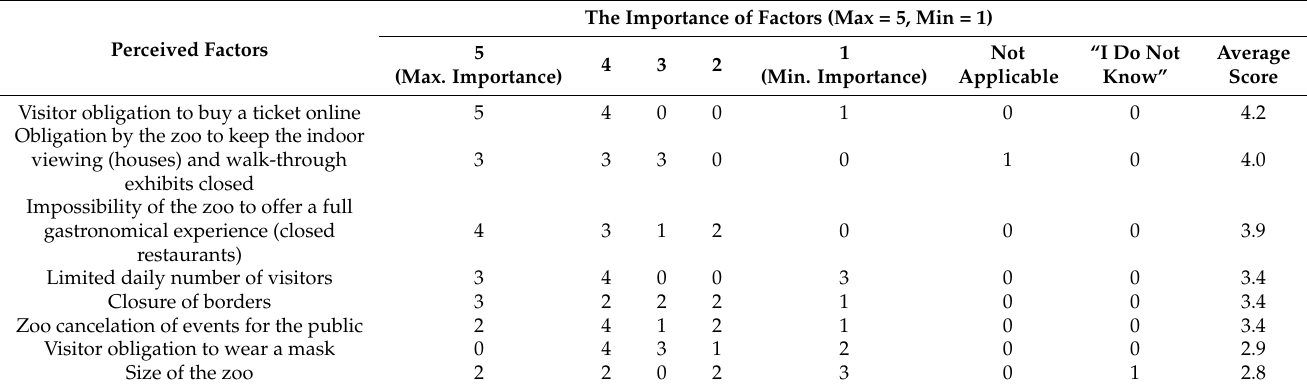
Table 1. Zoo staff responses to a question of the perceived importance of factors limiting zoo attendance, Czechia, spring 2020 ( N =